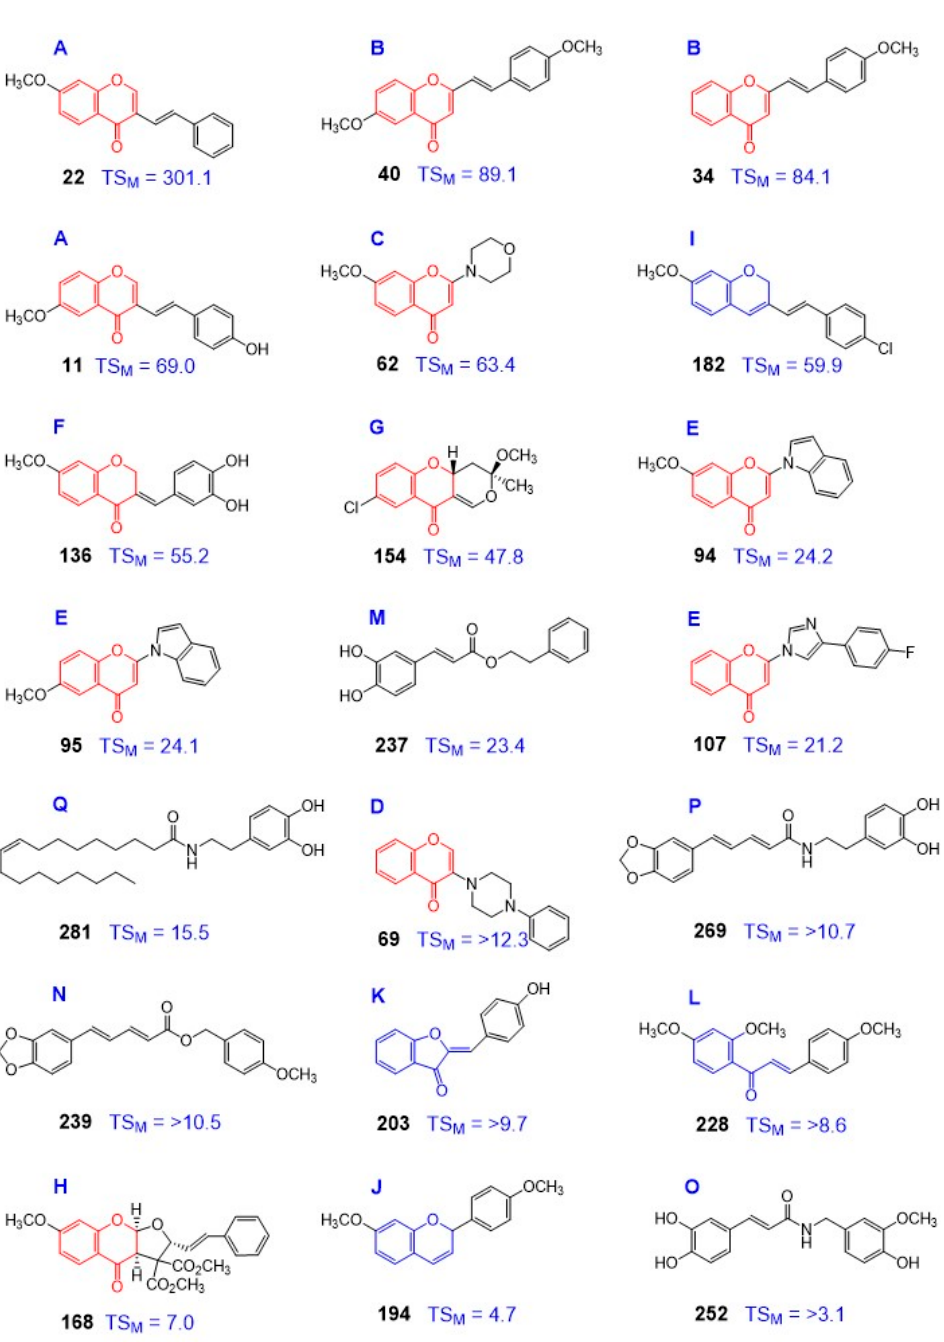
Figure 7. The most active compounds in each group, line-upped in the decreasing order of potency.